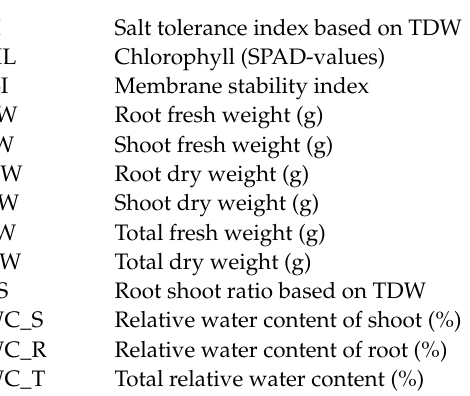
of correlation (r) between the fifteen morpho-physiological traits and nine ionic traits along with salt tolerance index (STI) evaluated at 150 mM NaCl, Table S4: Prediction screening showing the contribution of different traits among the wheat genotypes under salt stress